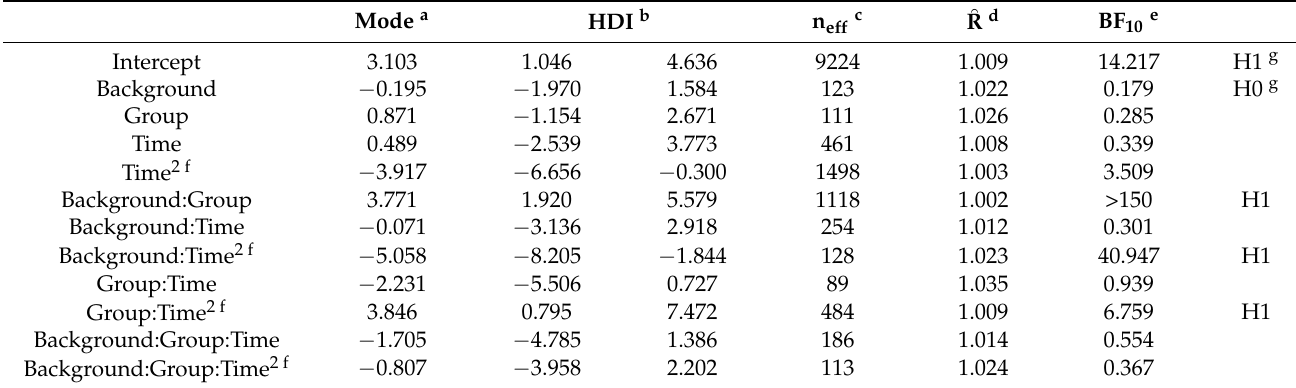
Table 4. Table of the results for the Bayesian model referring to the BST evaluations.